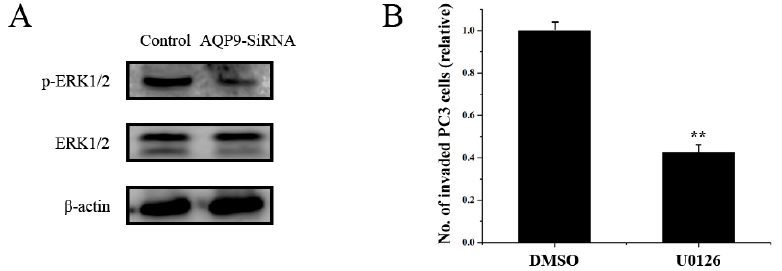
Figure 7. Cells were transfected with siAQP9. ( A ) After 48 h, Western blotting was performed to detect the phosphorylation of ERK1/2 ( p < 0.05 as compared with control). The phosphorylation of ERK1/2 was markedly suppressed in AQP9 siRNA-transfected cells compared with that in control cells. Control: wild-type cells; AQP9-siRNA: cells transfected with AQP9 specific small interfering RNA; ( B ) after PC3 cells were treated with U0126 (20 µM) or DMSO vehicle, an invasion assay were performed to compare the invasion abilities. The mean number of invaded cells in control group set as 1.0. Data were based on three independent experiments, and shown as mean ± SD, ** p < 0.01.